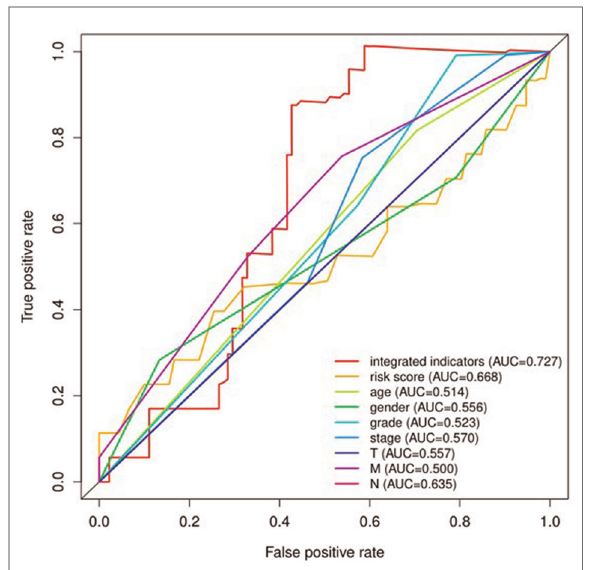
FIGURE 8 The receiver operating characteristic (ROC) curve analysis of risk scoreof the eight pyroptosis-related lncRNAs and other clinicopathological characteristics including age, gender, grade, T stage, M stage, N stage, and TNM comprehensive stage for predicting the overall survival of patients with oral squamous cell carcinoma. AUC, area under the curve.